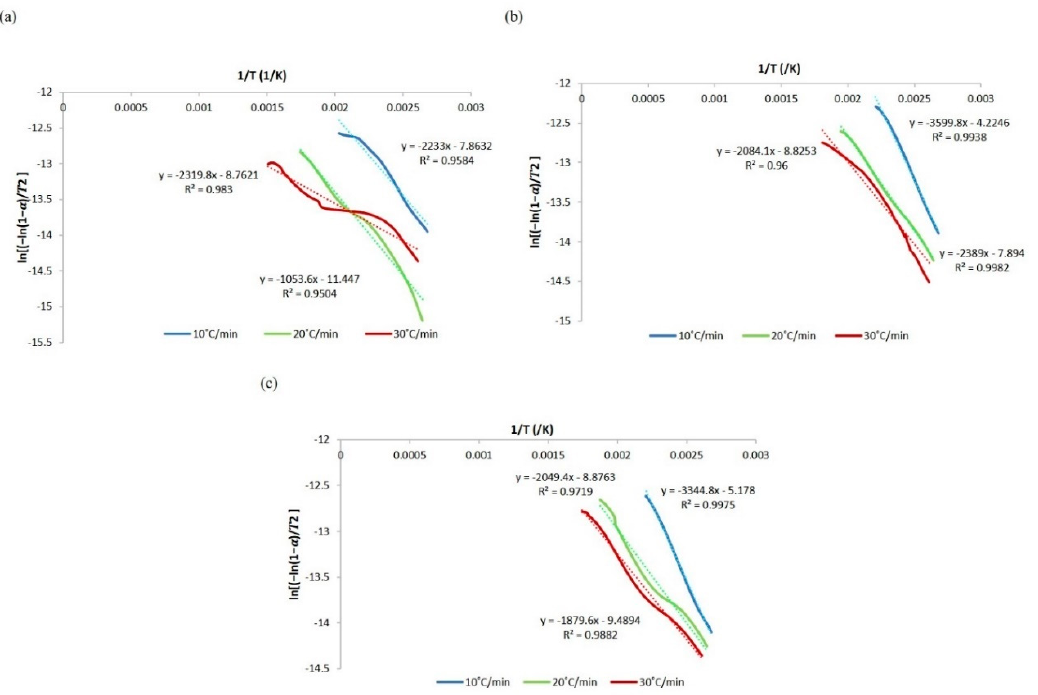
Figure 3. Coat-Redfern plot for kinetic parameters determination of ( a ) Caulerpa lentillifera ( b ) Gracilaria coronopifolia and ( c ) Chaetomorpha linum .